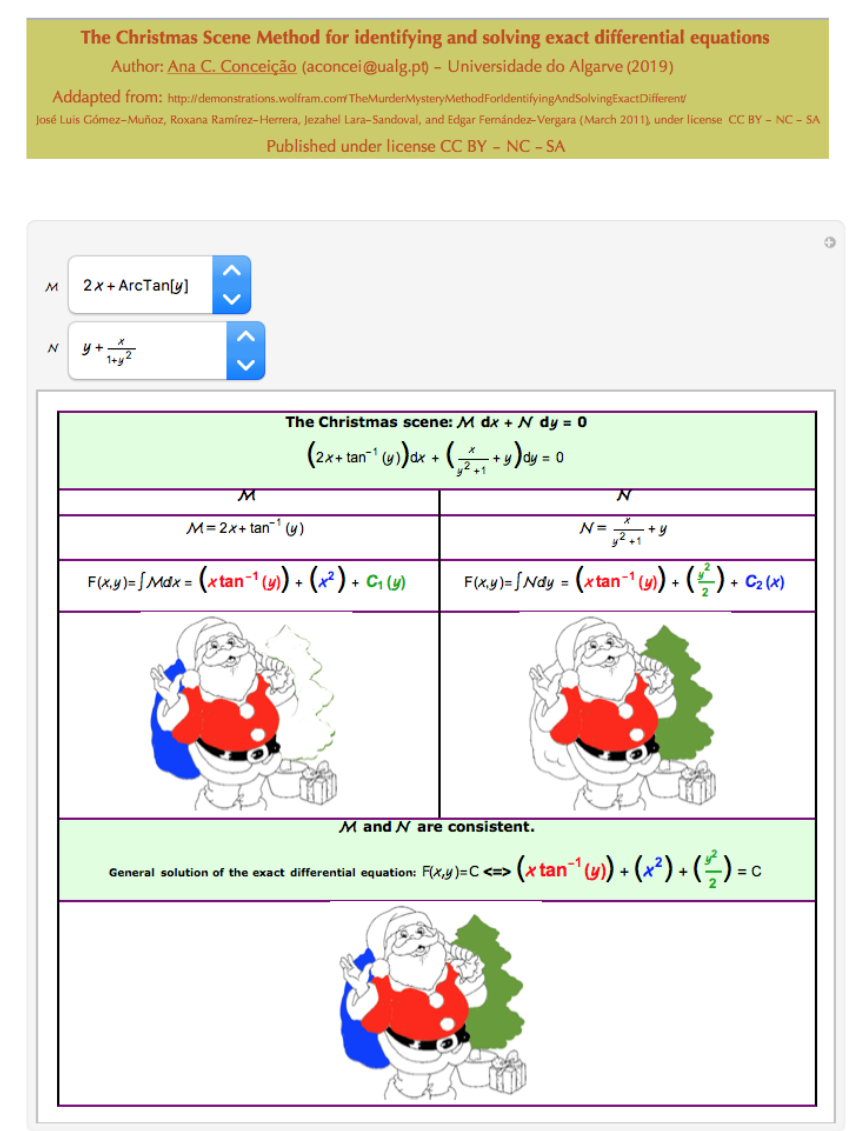
Figure 16. Image that illustrate an activity to be done in autonomous students’ work. The student must justify why it is an exact ODE and confirm all the computed